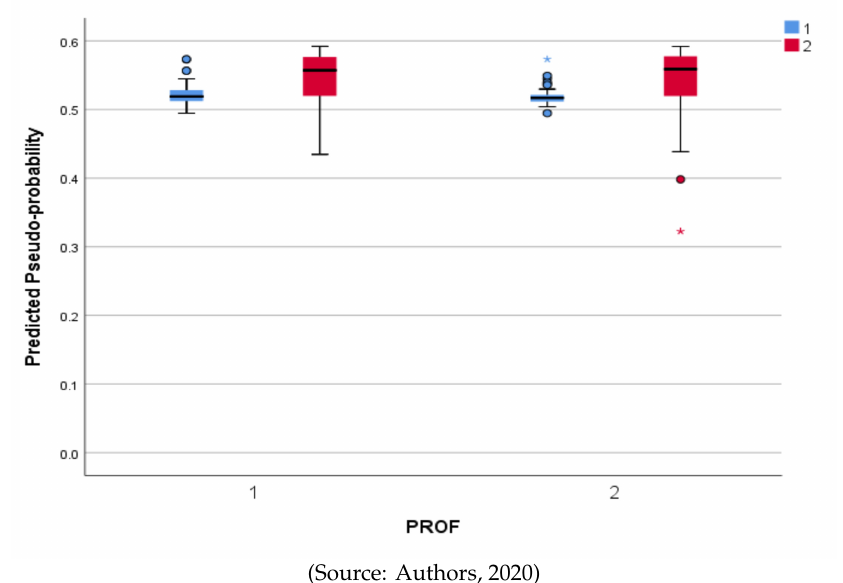
Figure 5. Validated predicted pseudo-probability for the